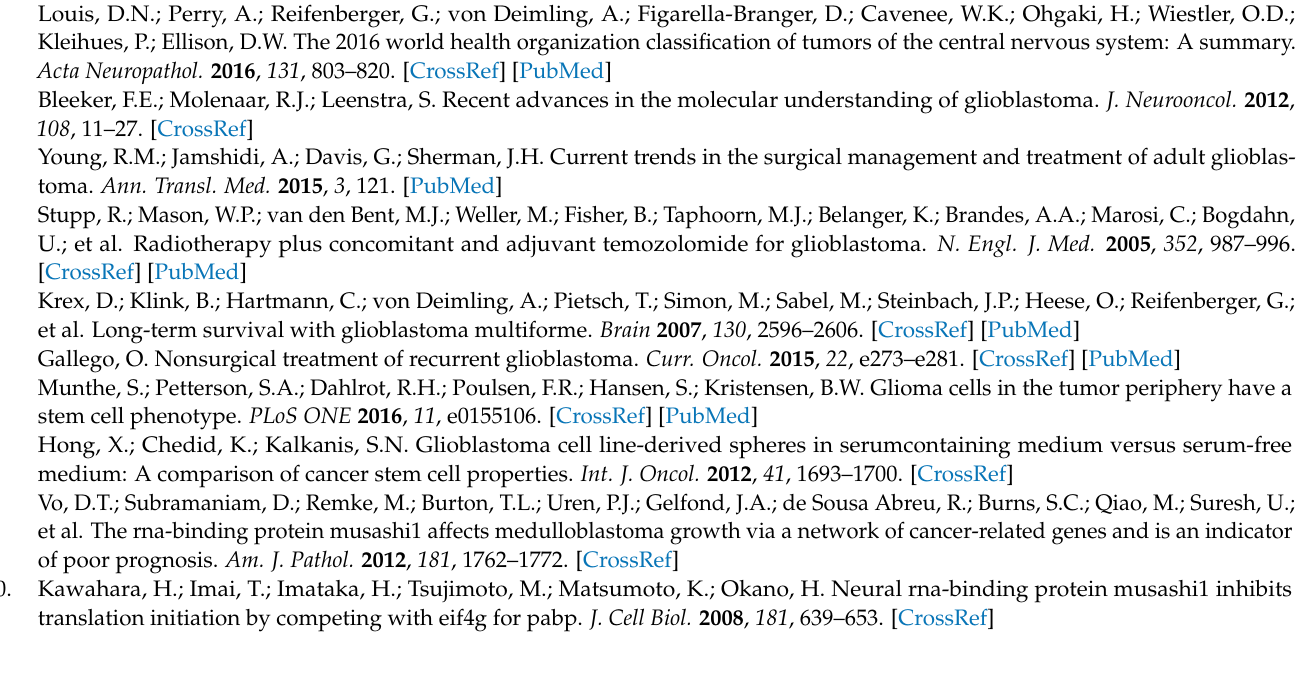
medium, Figure S2: Expresion of respective M1 and M2 macrophage markers, Table S1: Antibodies, Table S2: Primer sequences, Table S3: